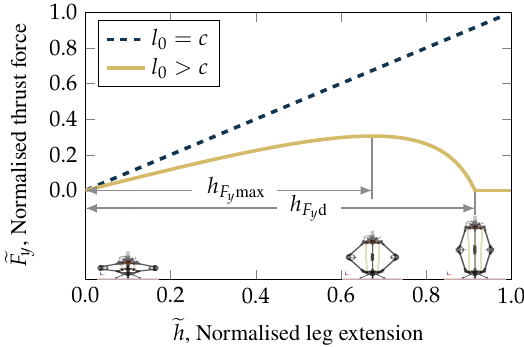
Figure 5. Thrust force vs. leg extension normalised to maximum values of l 0 = c , for equal leg length a = 1, k = 1 . The curves illustrate two relation cases for l 0 and c . For the sake of illustration l 0 c = 0.7 is used to cover the case l 0 > c . For l 0 = c , the force inversion observed in the hinge rhomb linkage is recovered. Conversely for l 0 > c the behaviour of nonlinear spring is created.